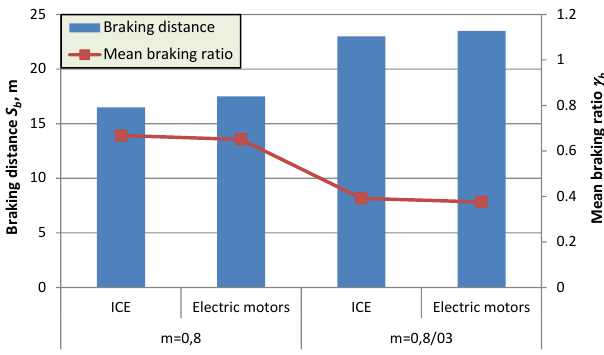
Fig. 13. Comparison of braking in an attempt to drive straight ahead on a road with high homogeneous and different adhesion coefficient under the wheels of the left and right side [own research]